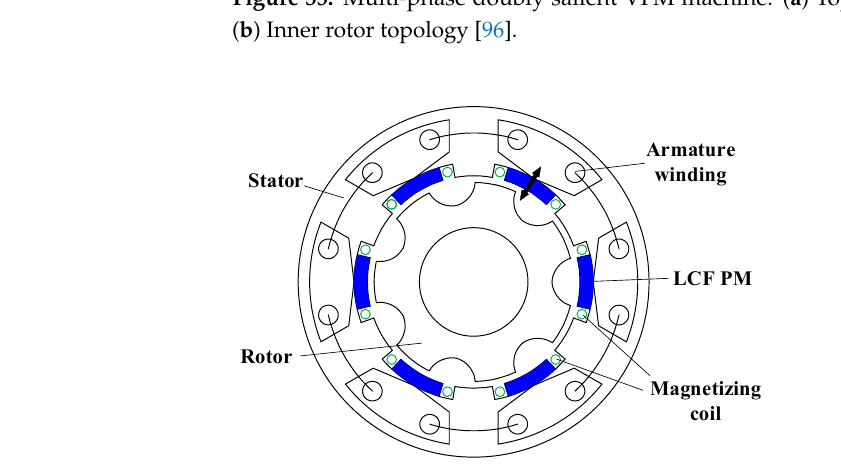
Figure 36. Consequent ‐ pole surface ‐ mounted stator ‐ PM VFM machine [98].